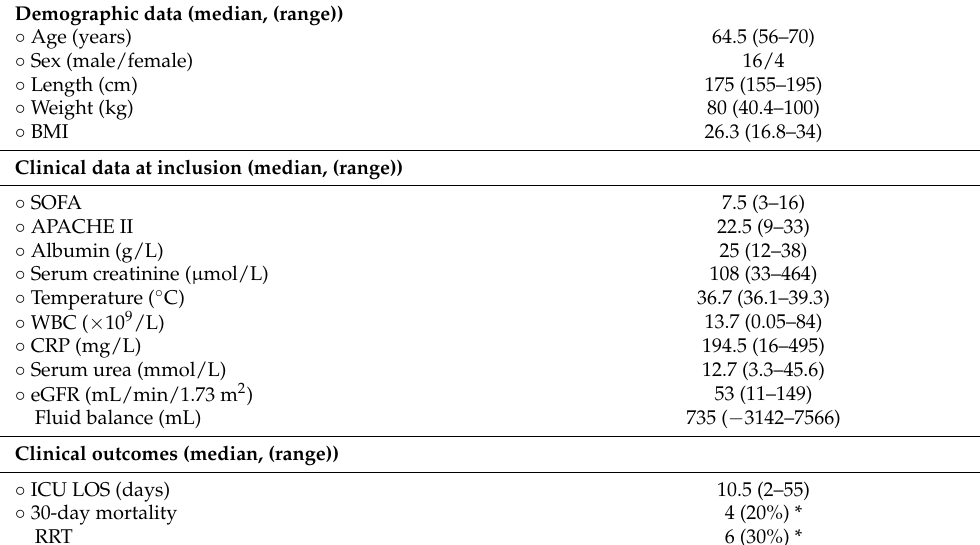
Table 1. Patient baseline